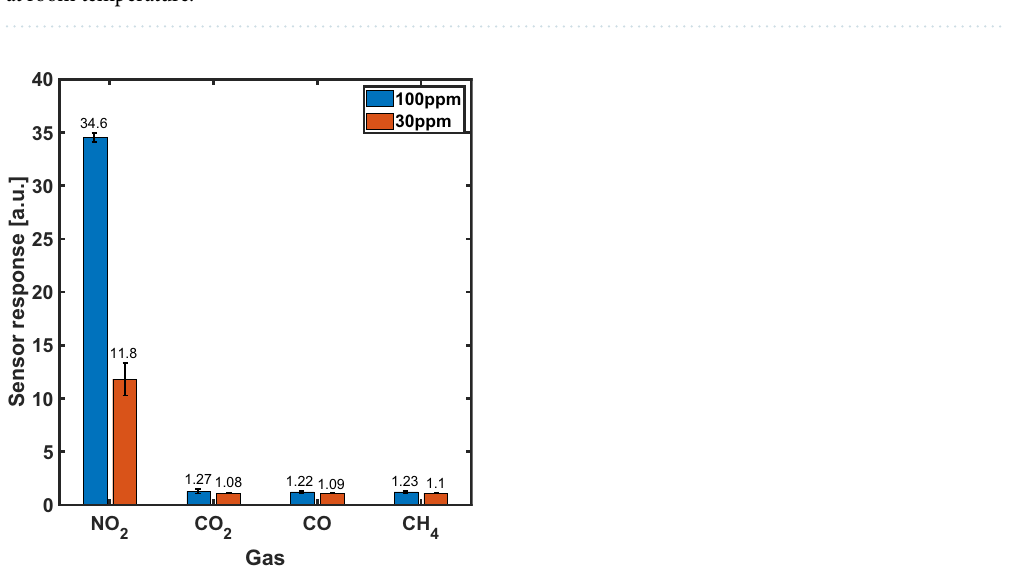
Figure 2. ( a ) Current–voltage characteristics in air atmosphere. ( b ) Real-time resistance change to 30 ppm NO 2 at room temperature.